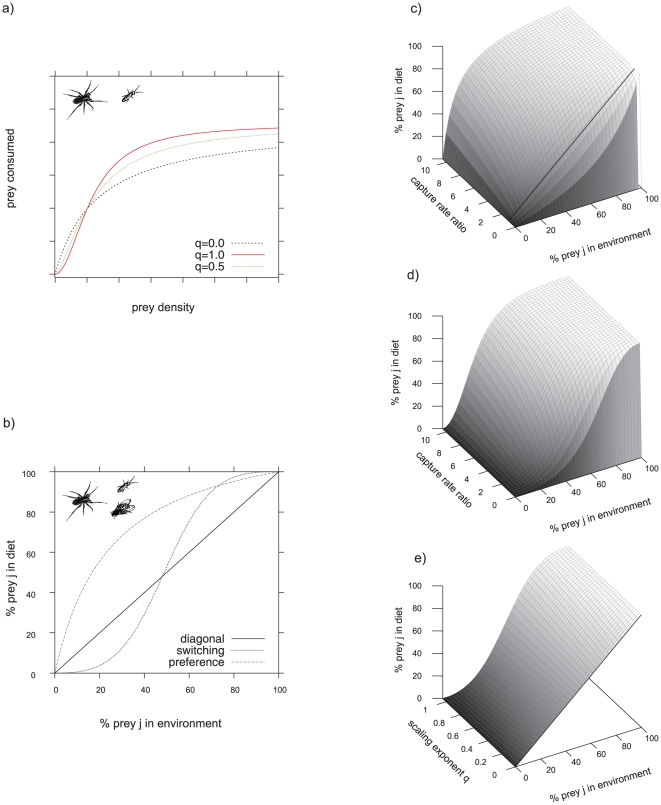
Conceptual illustrations of (a) type II and type III (single-prey) functional responses and the implications of variance in the scaling exponent q as well as consequences for absolute prey consumption and (b–e) preferences and switching in two-prey (here: j and k) experiments: b) “Traditional” preference plot with relative consumption depending on relative density of prey j: Consumption is strictly density-dependent (the diagonal solid line), or exhibits preferences for prey j (upper, long-dashed line) or switching behaviour (sigmoid, dotted line). c–e) Novel null model based on two-prey functional responses (Equation 3) with varying capture rate ratios (bij/bik with 0.01<bij<10 and bik = 1) for the two prey in c) type II (qij = qik = 0) and d) type III functional responses (qij = qik = 1). e) Gradual conversion of type II to type III functional responses when both prey are consumed with the same capture rate (bij = bik = 1). Constant handling time is used in figures c–e (Thij = Thik = 0.1). Note that the diagonal of strictly density-dependent consumption as the traditional null model (panel b) only emerges if both prey are consumed with exactly the same type II functional response (solid black lines in figures c and e).